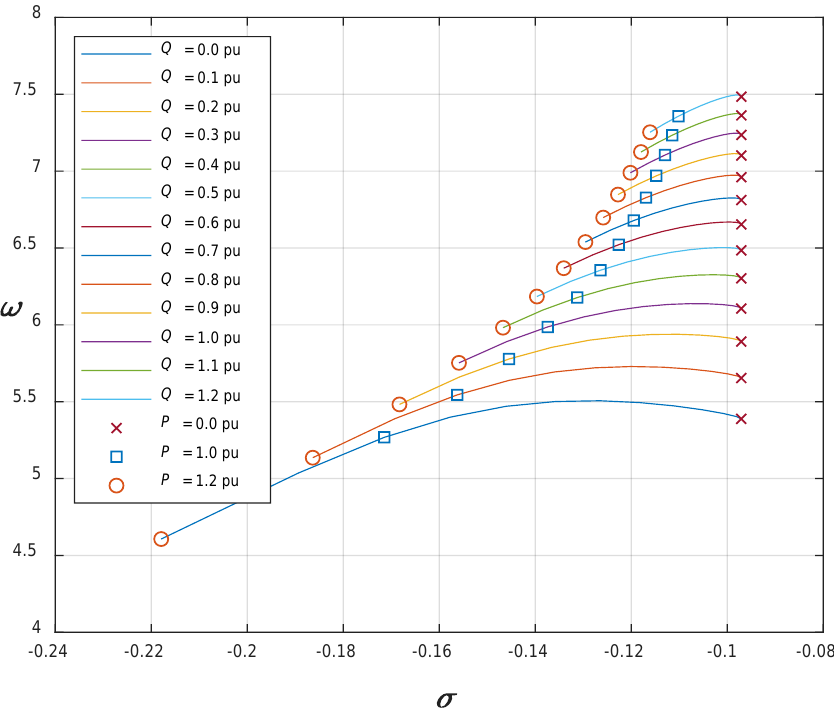
Figure 4. Eigenvalue loci of local mode of 615-MVA hydro-type synchronous generator without AVR.